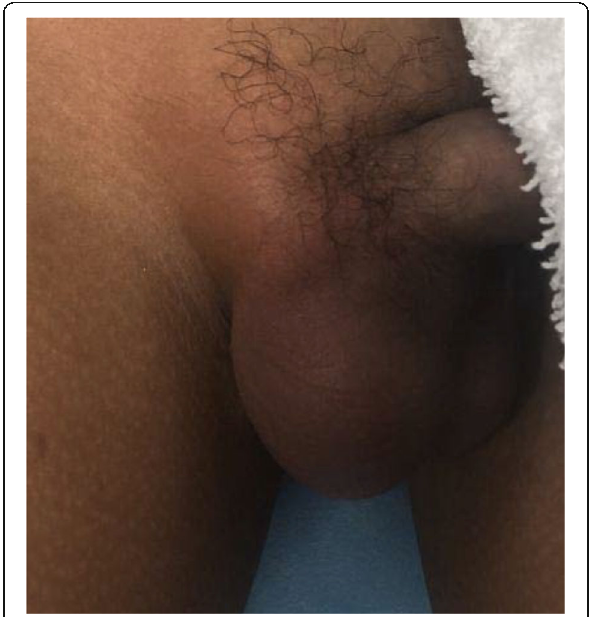
Fig. 1 Patient presented with nonreducible, erythematous right inguinal mass extreme tenderness to